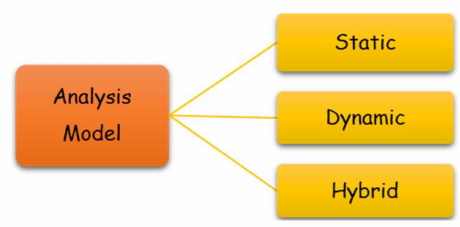
Figure 2. Structure of a PDF